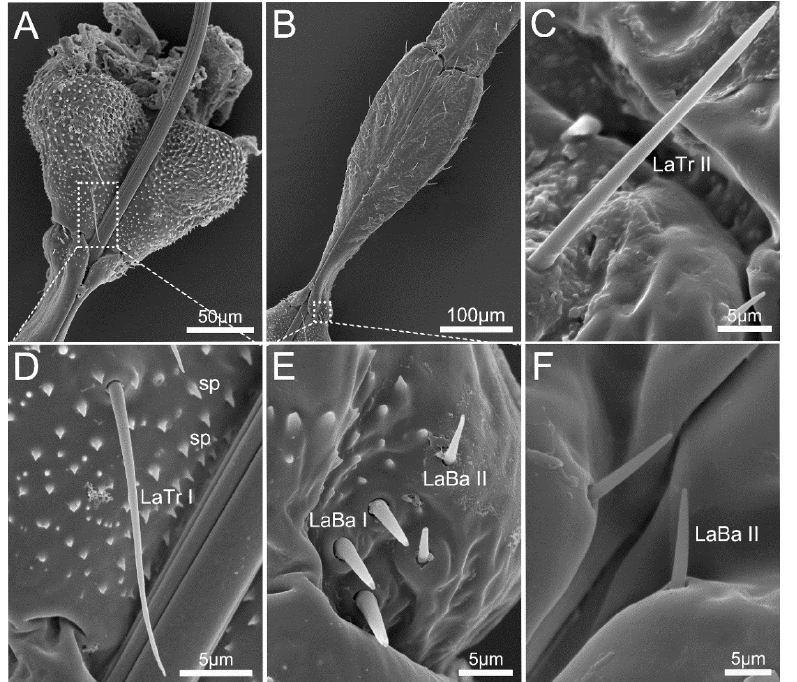
Figure 5. Labium of Mezira yunnana . ( A ) View of the first labial segment; ( B ) view of the second and third labial segments; ( C ) labial sensilla trichodea II (LaTr II); ( D ) labial sensilla trichodea I (LaTr I) and small spine-shaped projections (sp); ( E ) labial sensilla basiconica I (LaBa I) and labial sensilla basiconica II (LaBa II); ( F ) LaBa II near the junction.